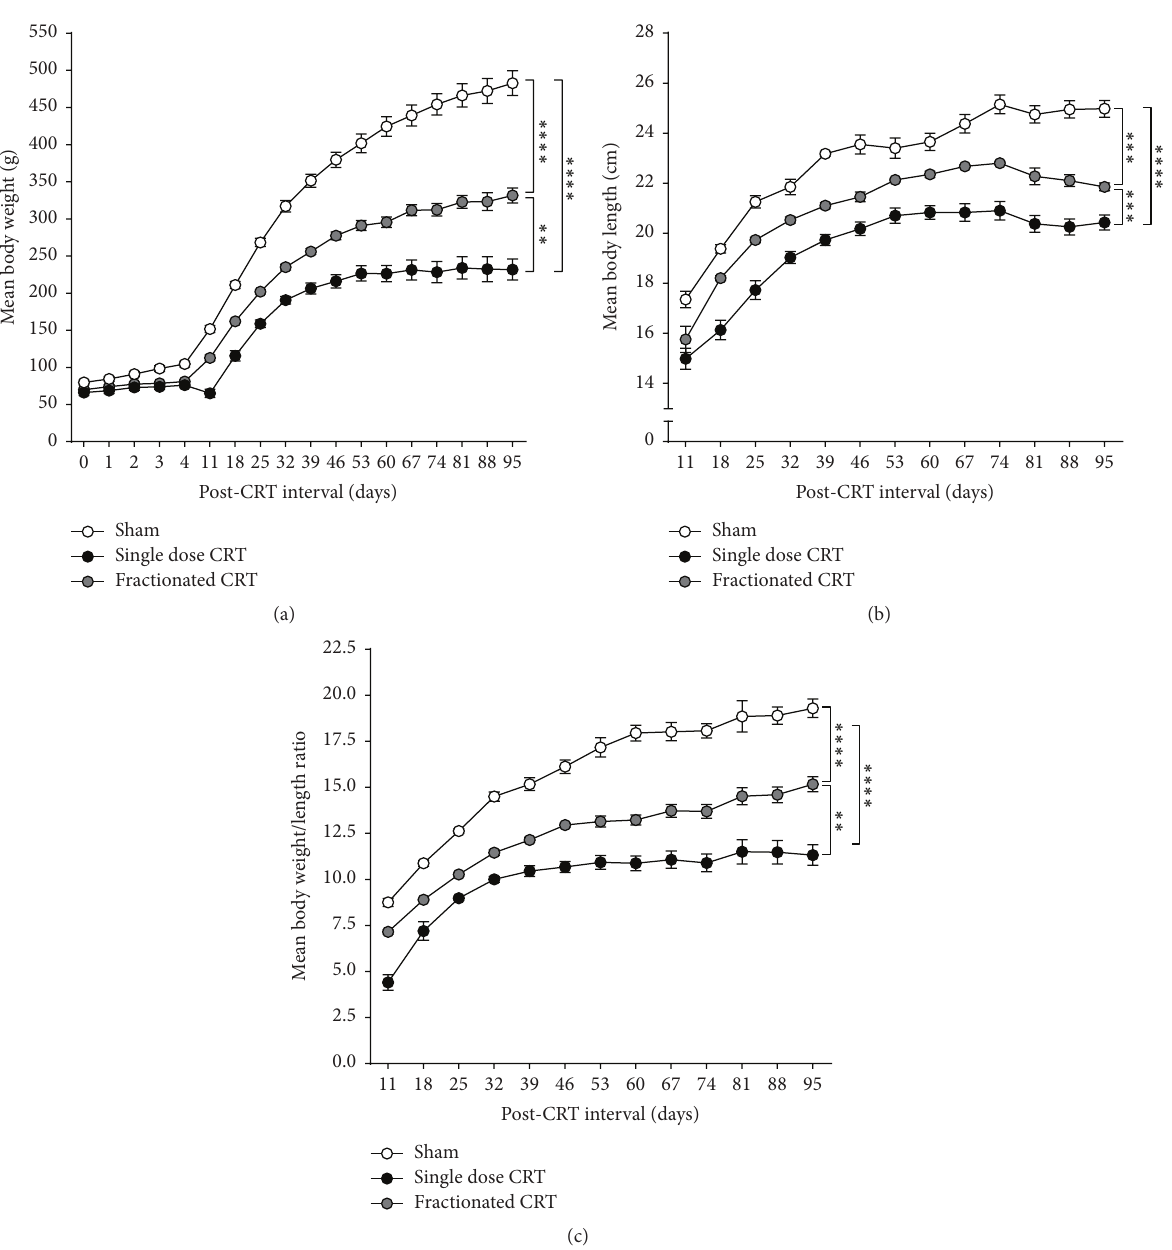
Figure 6: Eight male Wistar rats were irradiated at 28 days of age. They were randomly assigned to single dose CRT ( 𝑛 = 4 ) and fractionated CRT ( 𝑛 = 4 ) and irradiated as described in Methods. Age-matched shams ( 𝑛 = 4 ) were anesthetized but not irradiated. (a) Mean body weights ( ± SEM) before start of radiation (day 0), during the course of radiation (days 1–4), and every week for 12 weeks after CRT. (b) Mean body length ( ± SEM) from nose to tail for 12 weeks after CRT. Animals were placed ventral surface down on a surgical drape, while under anesthesia. Tip of the nose and base of the tail were marked on the drape and the distance between them was measured by the same experimenter throughout. (c) Mean body weight/body length ratio ( ± SEM) [ ∗∗∗∗ 𝑝 < 0.0001 , ∗∗∗ 𝑝 < 0.001 , ∗∗ 𝑝 < 0.01